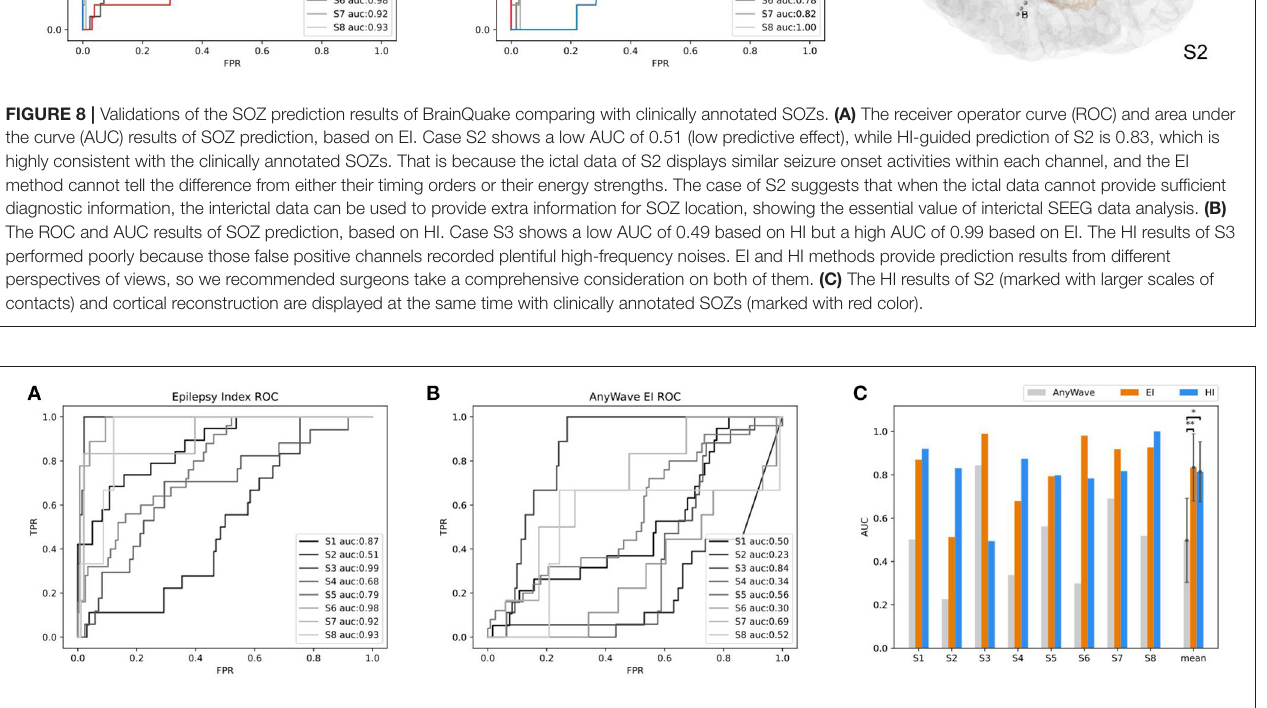
FIGURE 9 | Comparisons between AnyWave EI method and the EI and HI of BrainQuake. (A) The ROC and AUC results of SOZ predictions, based on BrainQuake EI. (B) The ROC and AUC results of SOZ prediction, based on AnyWave EI. In most cases, BrainQuake EI shows a greater prediction effect than AnyWave EI. (C) Comparisons of AUC values between AnyWave EI and BrainQuake EI and HI. A Wilcoxon signed-rank test was performed between the prediction results of AnyWave and BrainQuake. The AUC of BrainQuake EI and HI are both significantly higher than that of AnyWave EI ( p = 0.0078 and p = 0.0391, respectively, two-sided Wilcoxon signed-rank test, * p < 0.05, ** p <